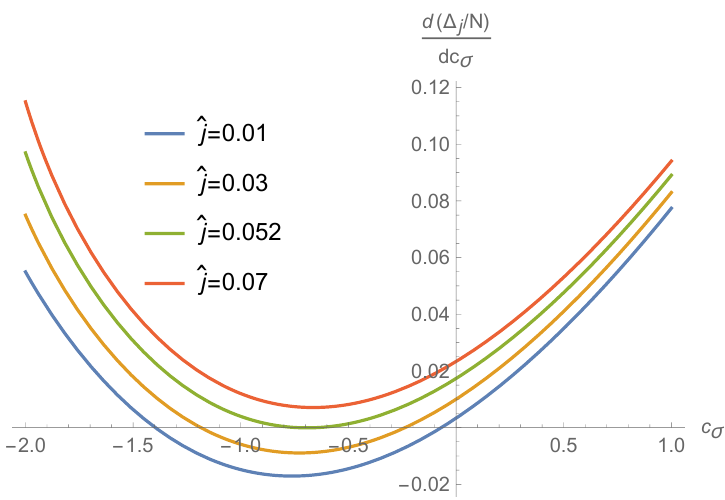
Figure 2 . Plot of the left-hand side of the saddle point equation (2.49) as a function of c σ in d = 5 , for several values of ˆ j = j/N . There are no real solutions for ˆ j > ˆ j crit ’ 0 . 052 . Similary, the scaling dimension at large ˆ j is complex in d = 6 − (cid:15) , where one finds ∆ − e ± i 4 π/ 5 5 N (2 (cid:15) ) 1 / 5 ˆ j 6 / 5 . 10 On the other hand, the small ˆ j expansion (2.52) still yields 3